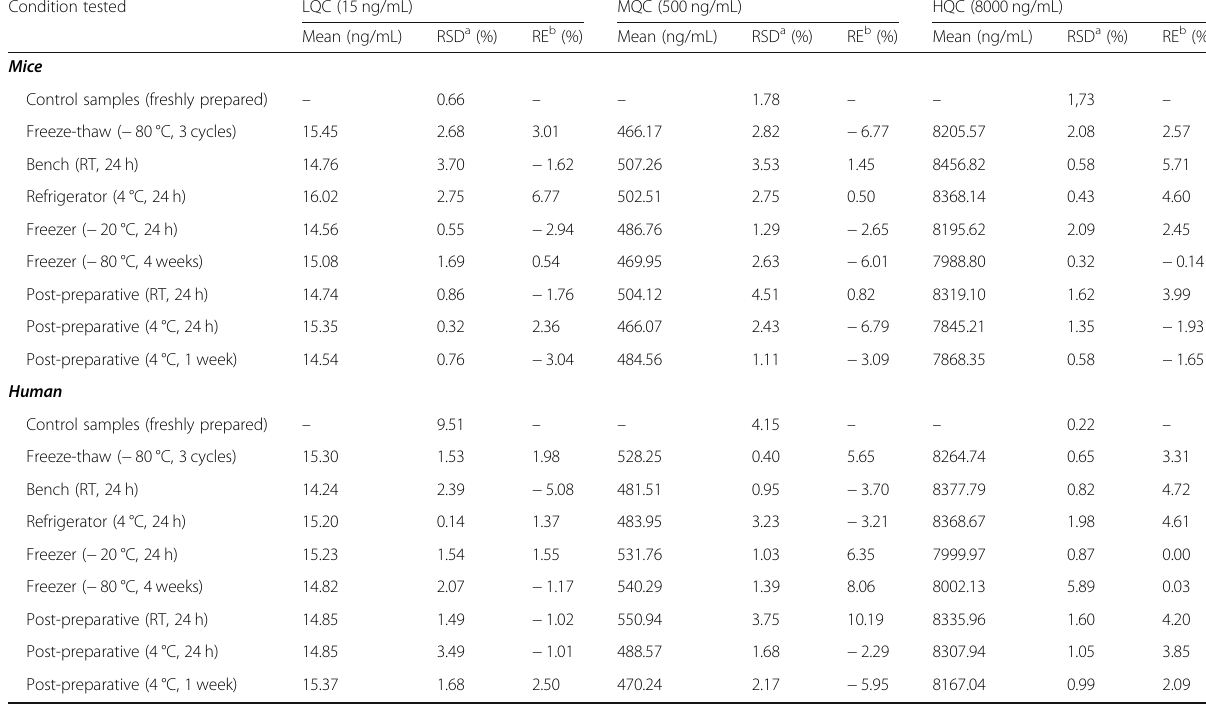
Table 3 Stability of larotrectinib in mice and human plasma ( n = 5)